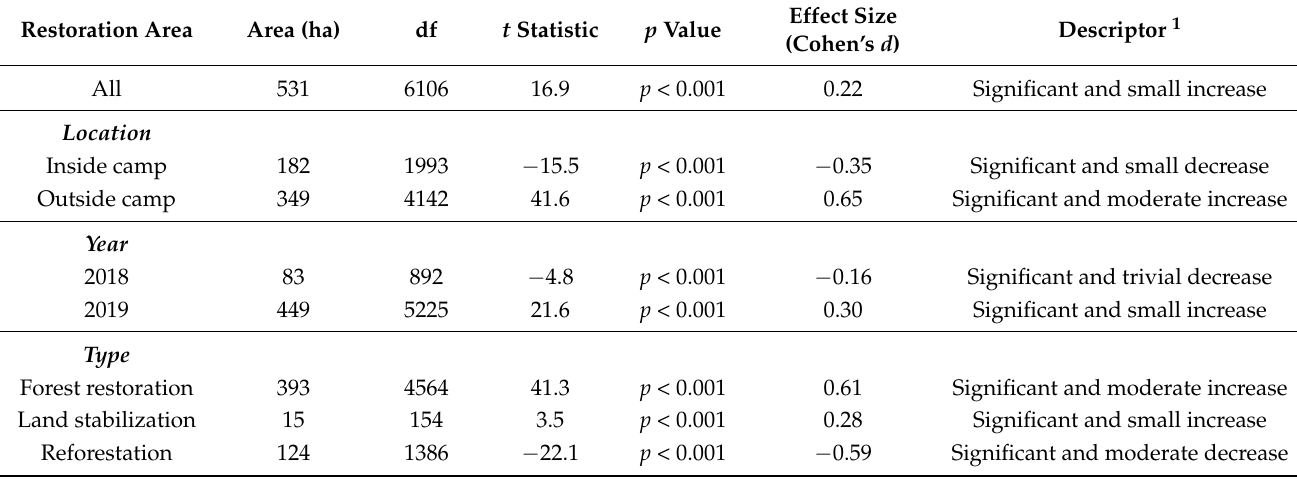
Table 5. Results from t